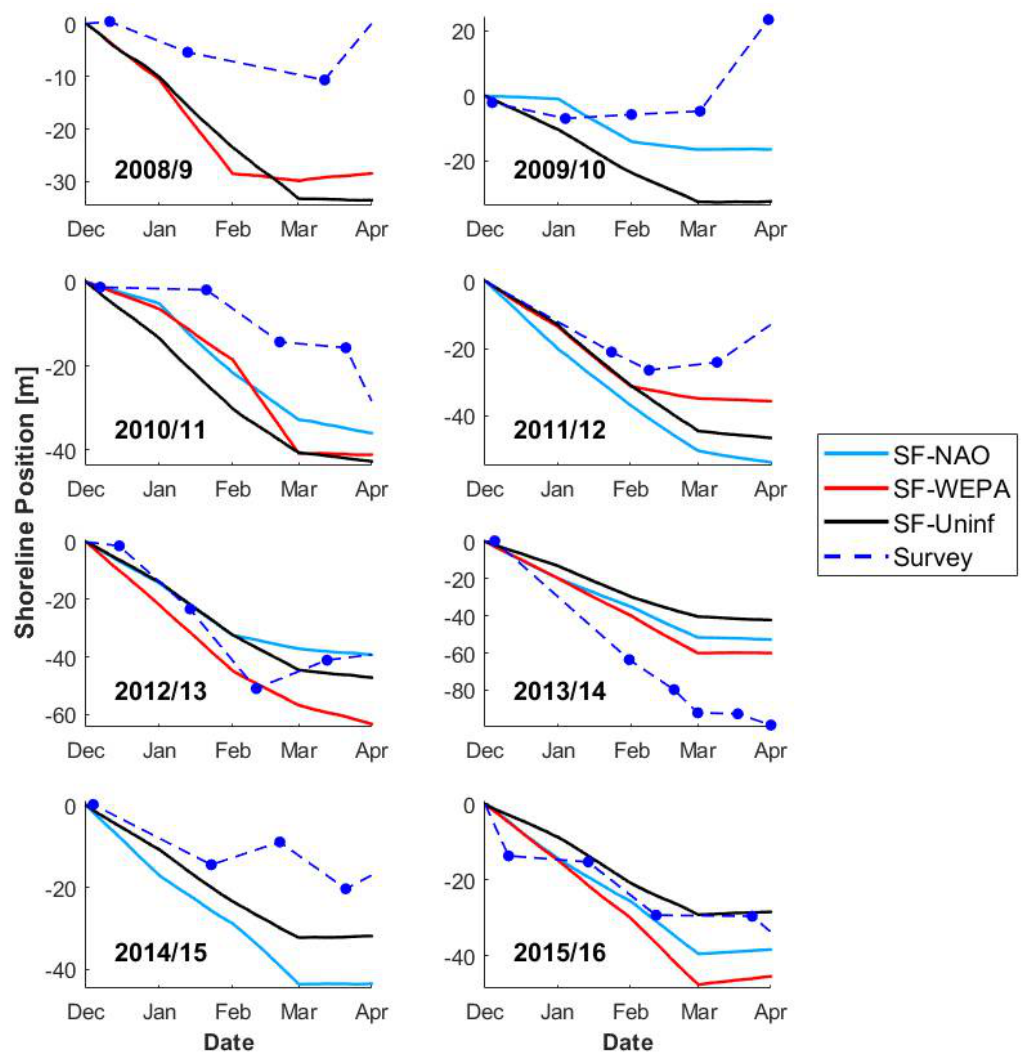
Figure 7. Compares the forecasts from SF-Uninf (black), SF-NAO (light blue) and SF-WEPA (red) to surveyed shorelines (blue dashed) for all eight winter seasons.